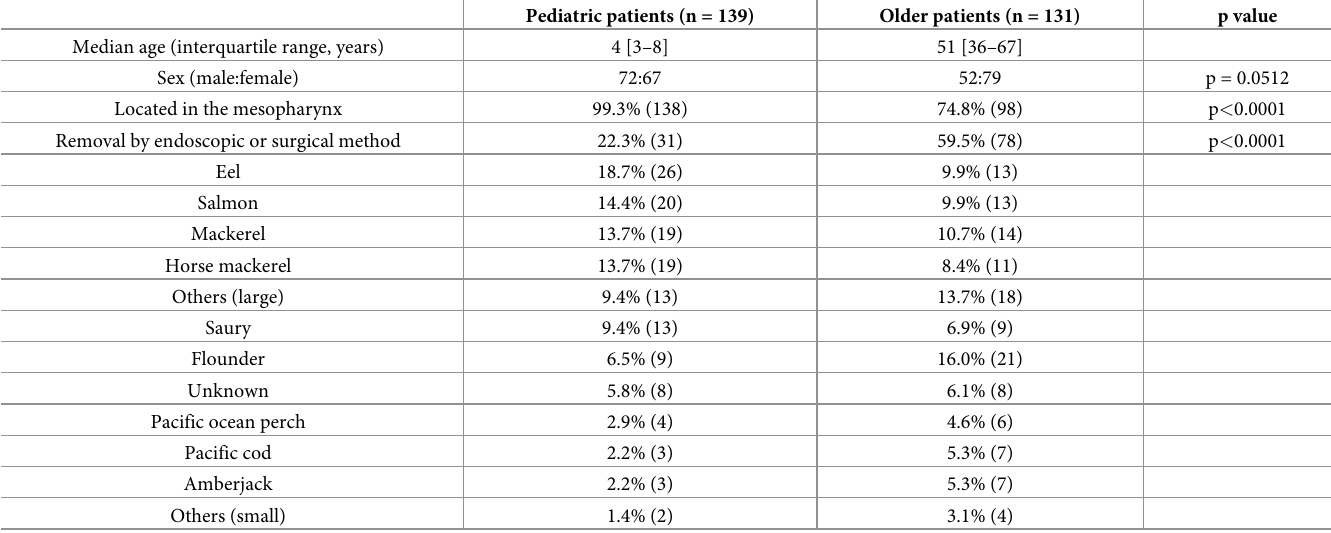
Table 4. The differences between pediatric patients ( < 12 years of age) and older patients in relation to sex, location (mesopharynx or other locations), removal methods (endoscopic removal/surgery or other methods), and fish